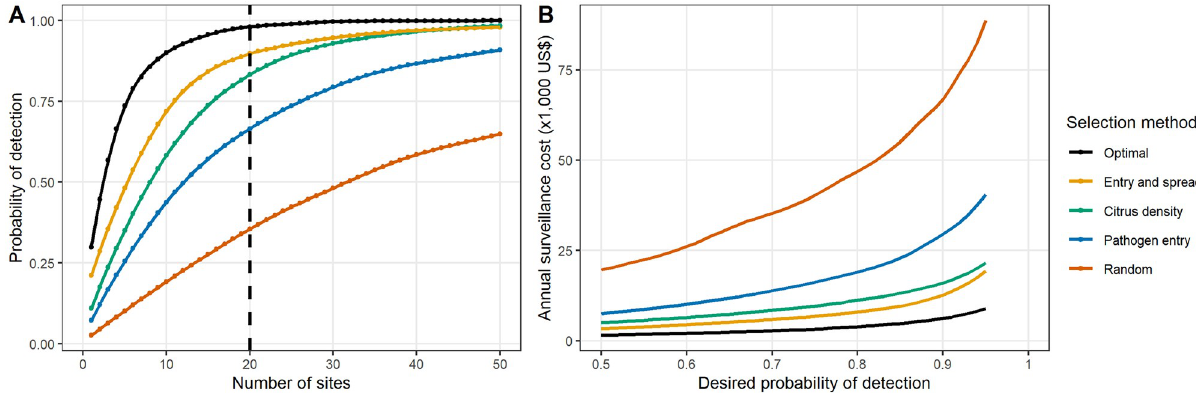
Fig 5. Impact of varying sample size on detection probability. These plots show the effect of varying the number of sites—and therefore also the expected cost of surveillance—on the detection probability before the threshold prevalence is reached. Again, we consider a range of selection strategies: an optimised arrangement (based in this case on a single optimisation run for each number of sites) and 100 runs of a weighted sampling strategy based on 4 different ‘risk metrics’. These risk metrics are the product of travel census probabilities and citrus density (‘Entry and spread’), citrus density, probability of entry according to the travel census model (‘Pathogen entry’), and random (that is, unweighted) selection. Estimates of the probability of detection were made for all numbers of sites between 1 and 50 for all selection methods and additionally for all numbers of sites between 51 and 150 for the risk metric strategies, and estimates of the detection probability were interpolated using locally weighted regression. Plot A shows the mean probability of detection for a range of different numbers of sampling locations and demonstrates the variation in probability of detection for any given sample size, with the vertical dashed line representing the ‘baseline’ scenario of 20 sites. Plot B shows the mean expected annual surveillance costs required to achieve any given probability of detection between 0.50 and 0.95 for the different selection strategies. We assume that the total surveillance cost is the product of the number of sampling sites and the per-site cost of surveillance, as described in the text. The data used to create these plots can be found at https://doi.org/10.17866/rd.salford.12759929.v1 (files ‘optimisationOutputs_numSites.csv’ and ‘costEstimates.csv’).